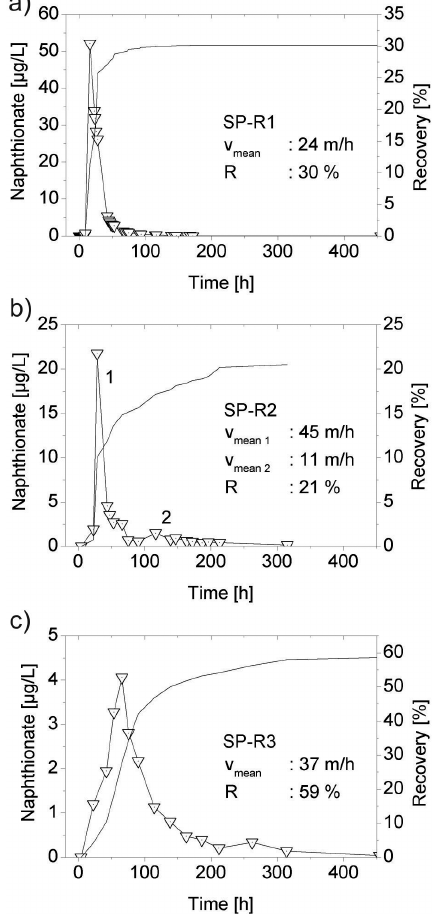
Figure 7. Naphthionate breakthrough curves at sampling points SP- R1 (a) , SP-R2 (b) , and SP-R3 (c) in the Reintal. Sampling points were located in the river bed and show dispersion of the tracer downstream the injection point. Total recovery was measured at the outlet of the system at